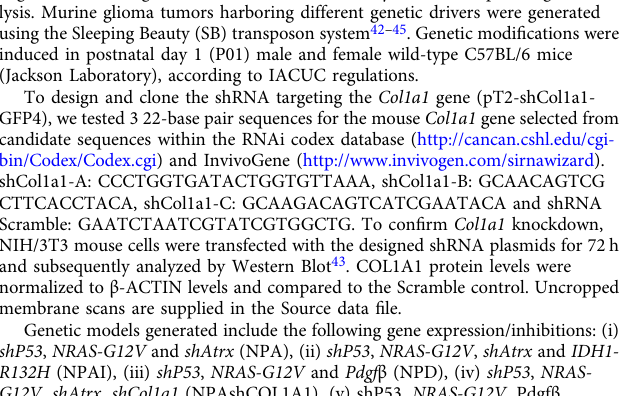
points. I Sinuosity of the border for all experiments. NPA: n = 6 and NPAshCOL1A1: n = 5 tumors for each experimental condition were used for